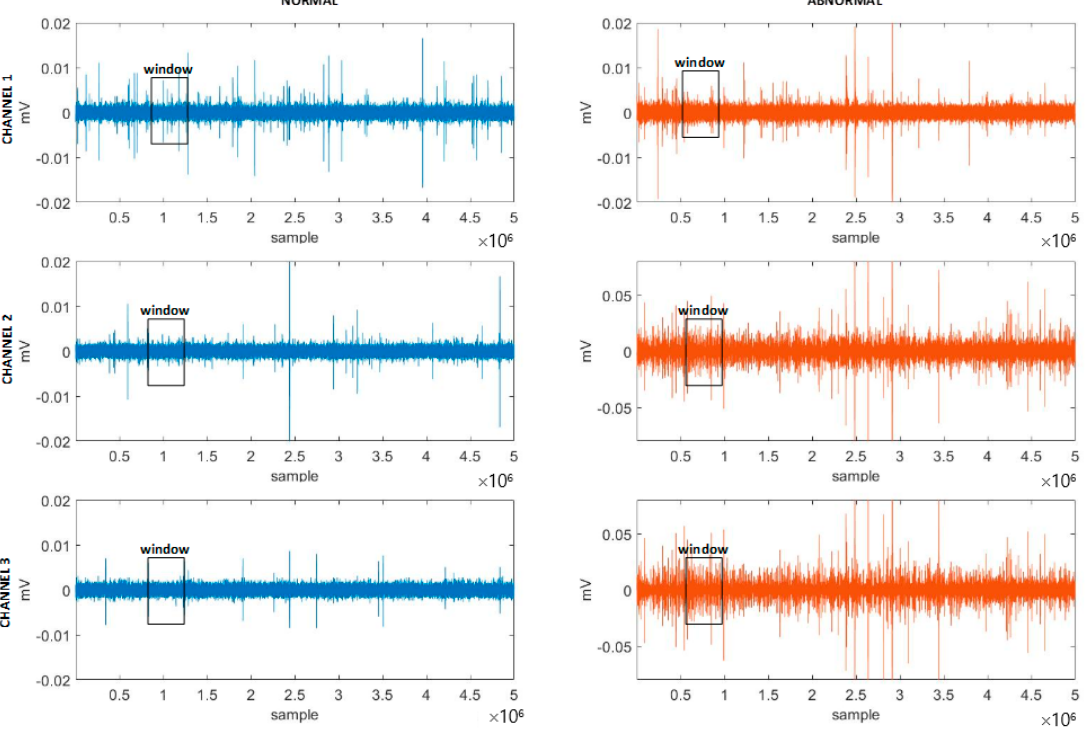
Figure 9. Datasets of the pair (P1, L1).